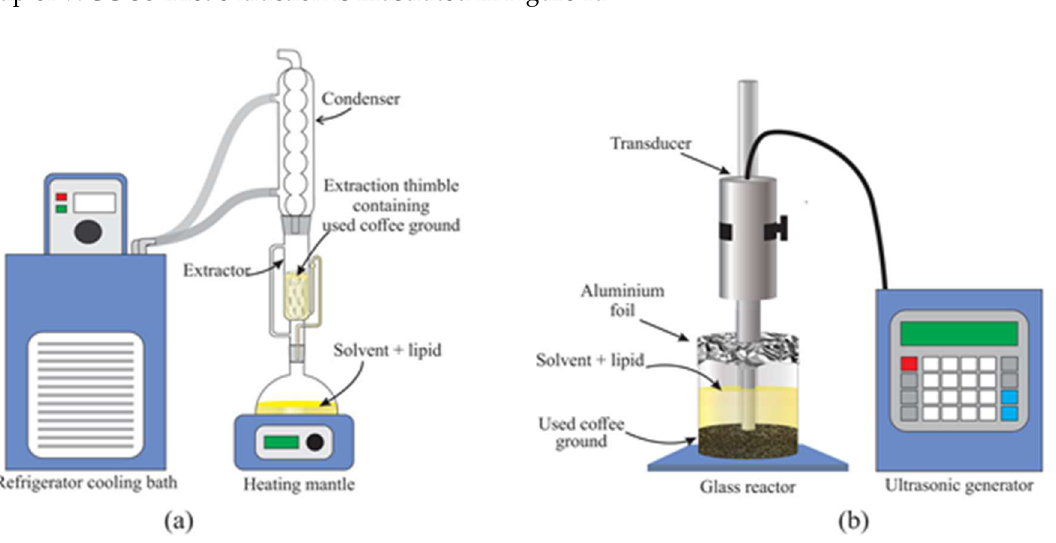
Table 1. Mass change of waste coffee grounds (WCG) with drying time.